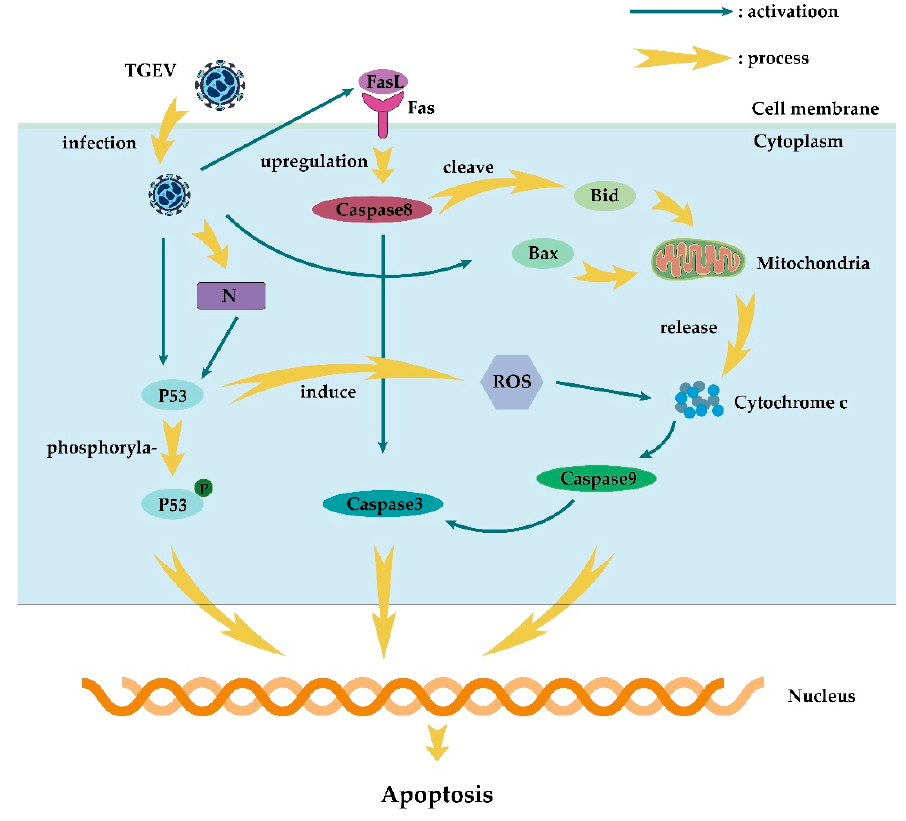
Figure 2. Diagram of the roles of apoptosis in the TGEV infection.